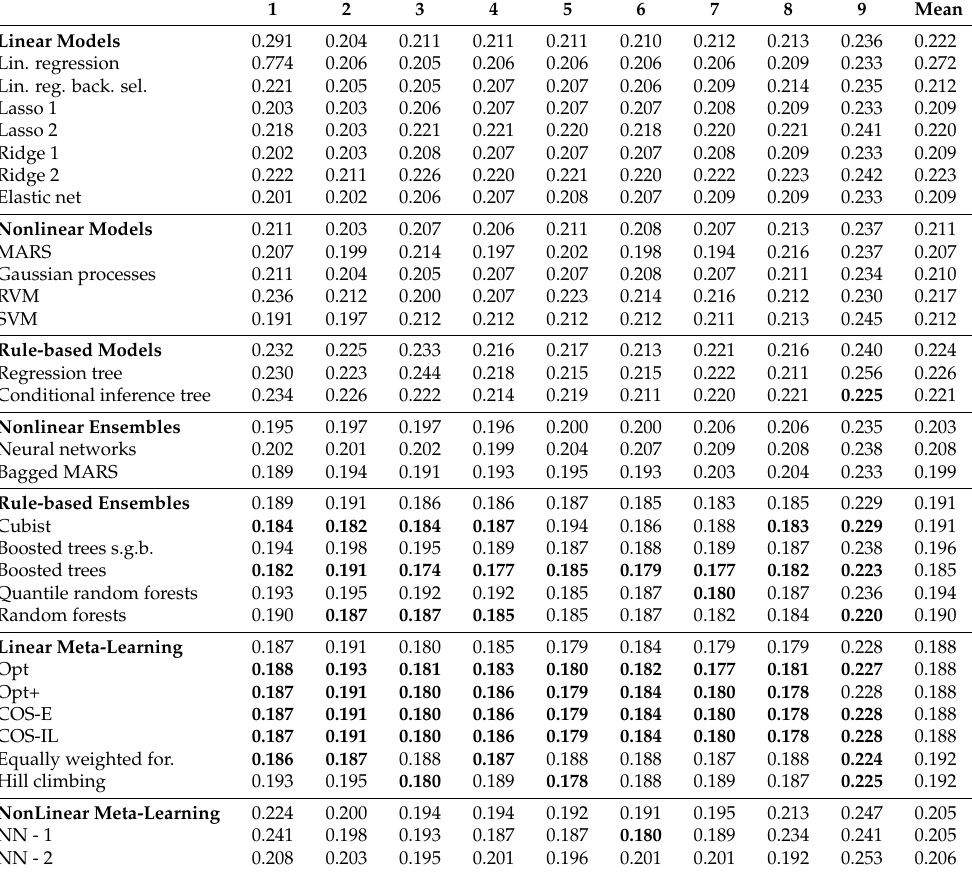
Table 11. Out-of-sample root mean square error (RMSE) metrics across model specifications. We indicate in bold the RMSE of the models that join the superior set of models with 10% confidence